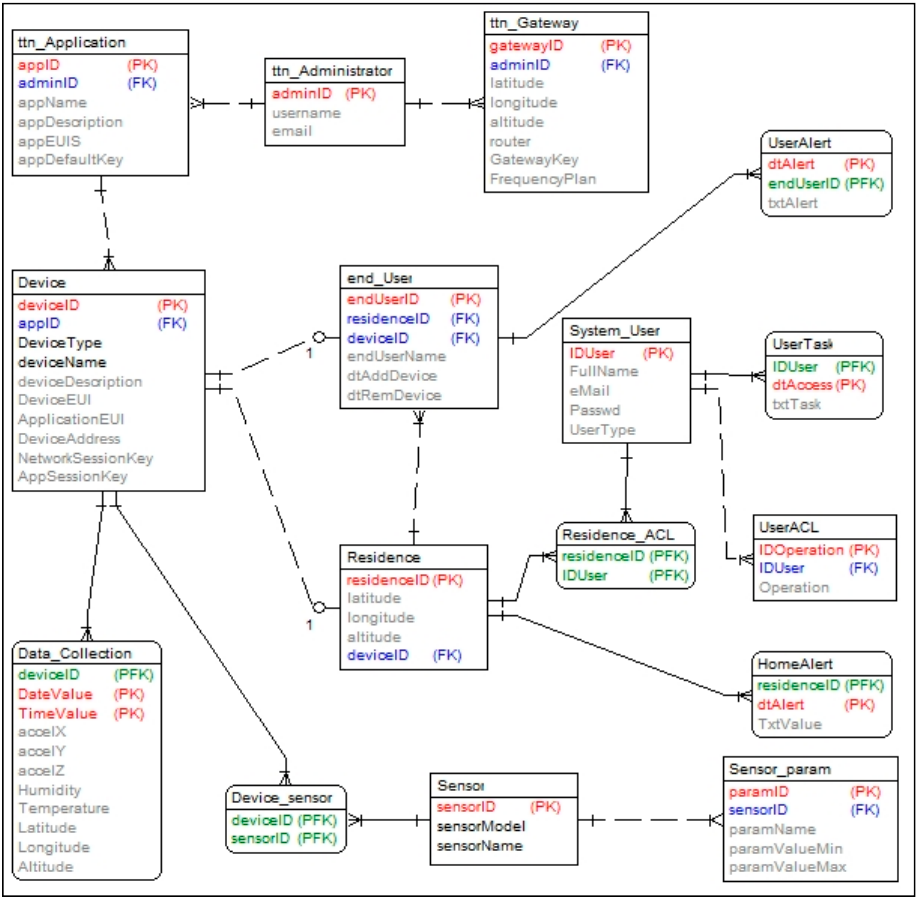
Figure 2. Entity Relational Diagram for IS4HMET.